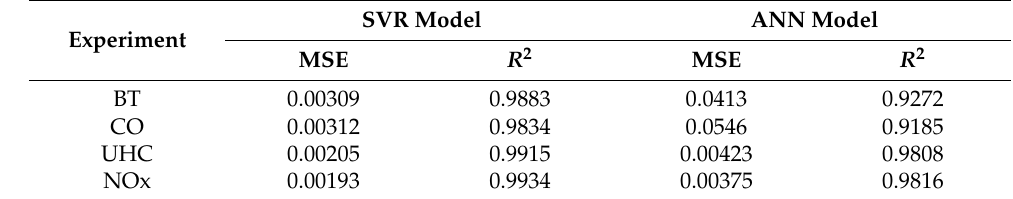
Table 7. Statistical comparison of the SVR prediction model to the ANN model.